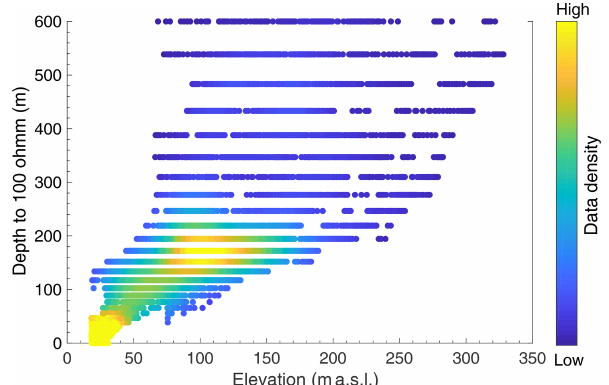
Figure 9. Elevation in meters above sea level (ma.s.l.) versus depth to 100 (cid:127) m brine–permafrost boundary in Fryxell basin. Each point represents an individual SkyTEM node (shown as the flight lines in Fig. 6). Data density is displayed as a color ramp, where yellow points indicate higher data density, and blue points indicate lower data density.